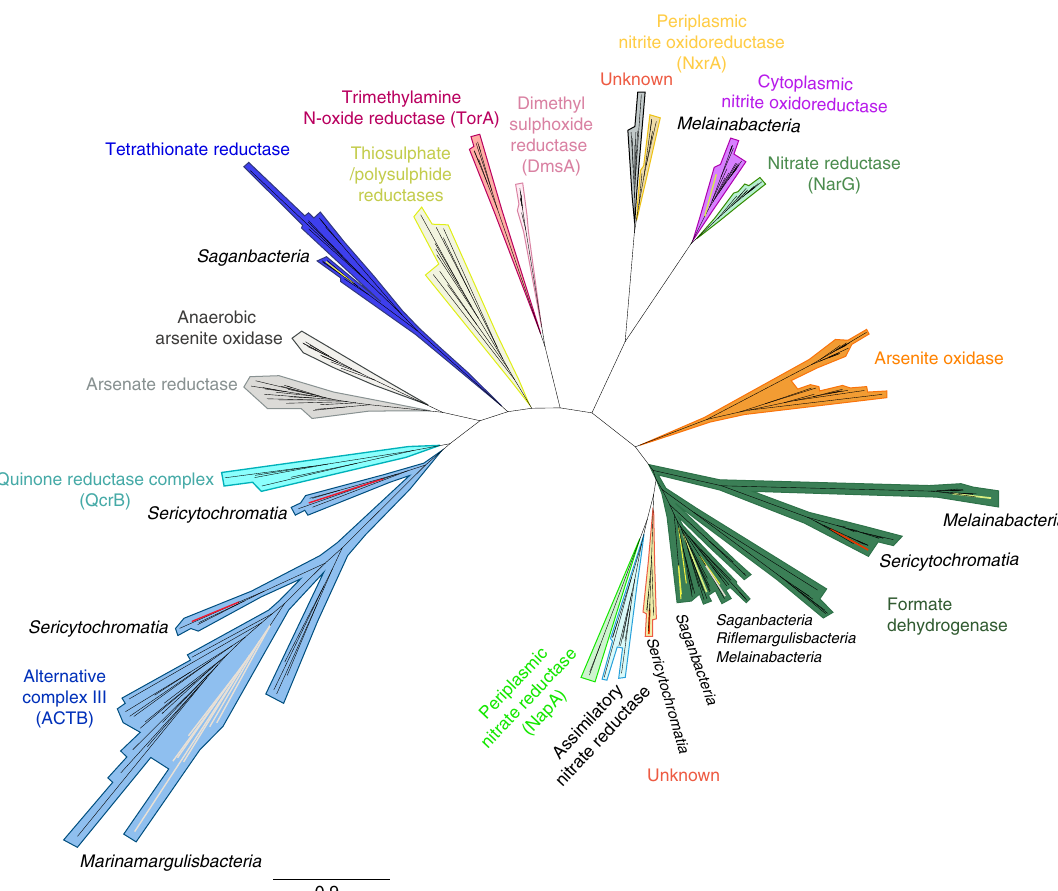
Fig. 5 Phylogenetic analysis of the dimethyl sulfoxide (DMSO) reductase superfamily. Catalytic subunits of a formate dehydrogenase (FdhA) were found in Ri fl emargulisbacteria, Saganbacteria, and Melainabacteria (also present in some Cyanobacteria). An Alternative Complex III (ACIII; ActB subunit) was found in Marinamargulisbacteria, as well as in Sericytochromatia LSPB_72 and CBMW_12 7 . Subunit A (TtrA) of a tetrathionate reductase was identi fi ed in Saganbacteria. A cytoplasmic nitrate/nitrite oxidoreductase (NXR) was identi fi ed in Melainabacteria in this study. The tree is available with full bootstrap values in Newick format in Supplementary Data